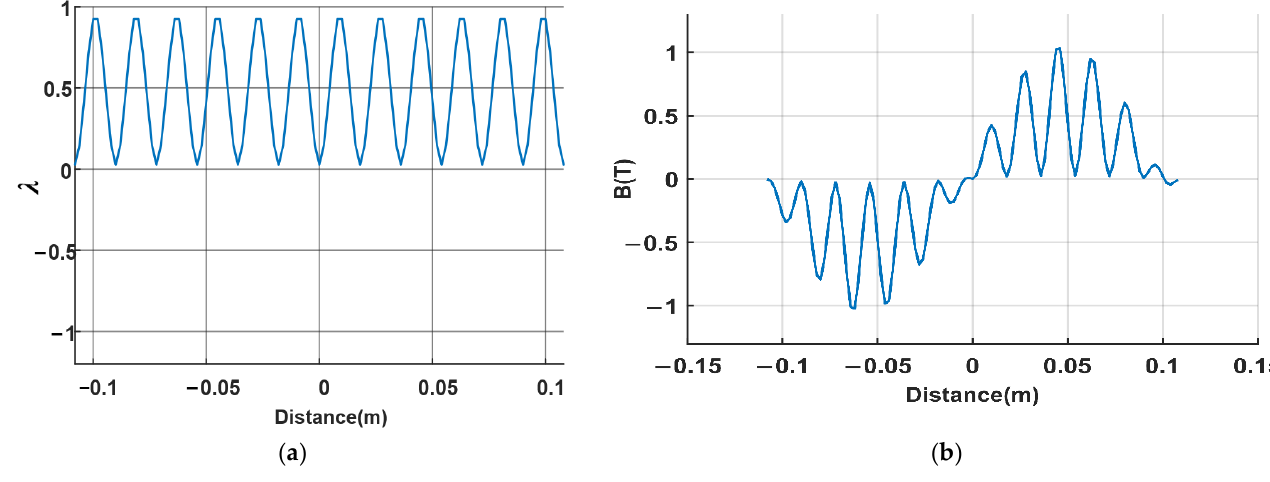
Figure 10. Distribution of air-gap relative permeance and flux density within the length range of the UP-LPST. ( a ) Air-gap relative permeance; ( b ) distribution of air-gap flux density under the influence of cogging and end.